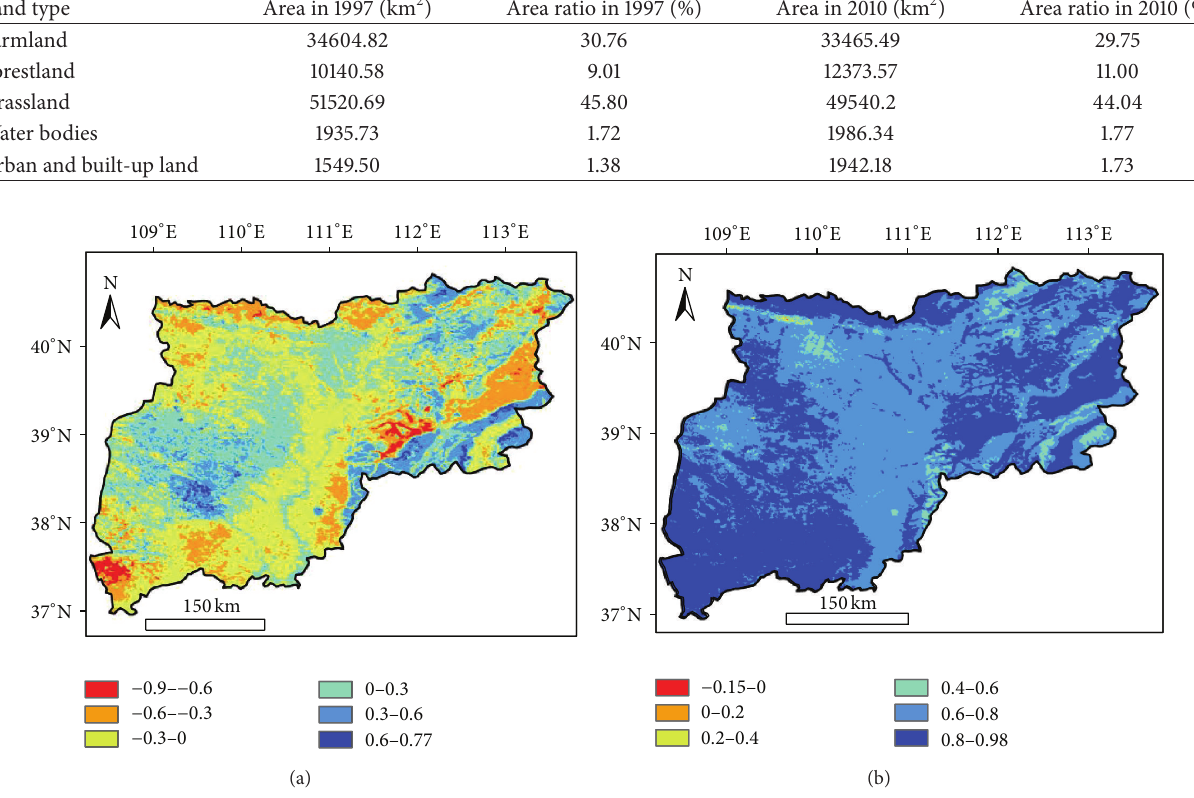
Figure 7: Correlation relationship between the monthly NDVI and monthly (a) mean temperature and (b) precipitation on the northern Loess Plateau from 1998 to